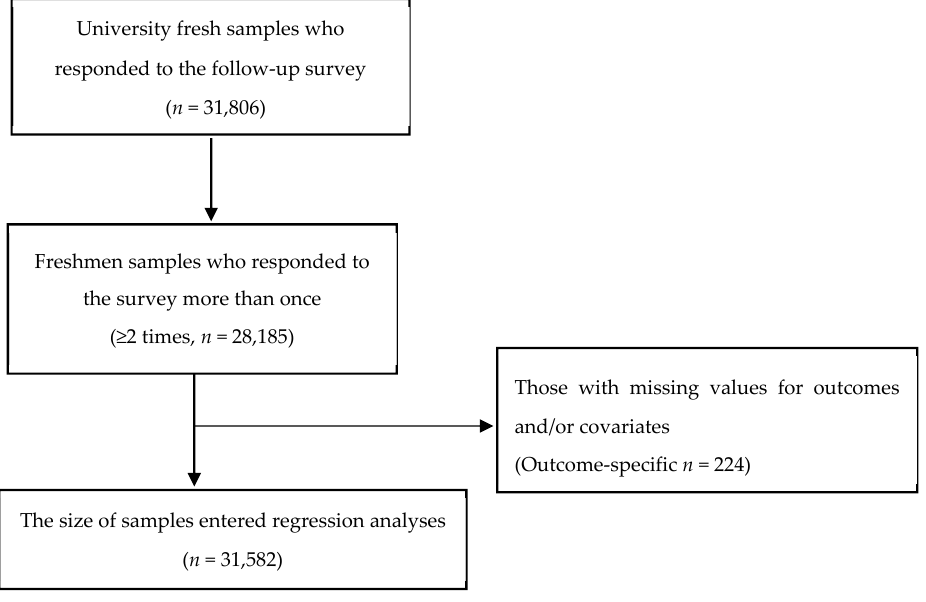
Figure 1. Study sample flowchart.